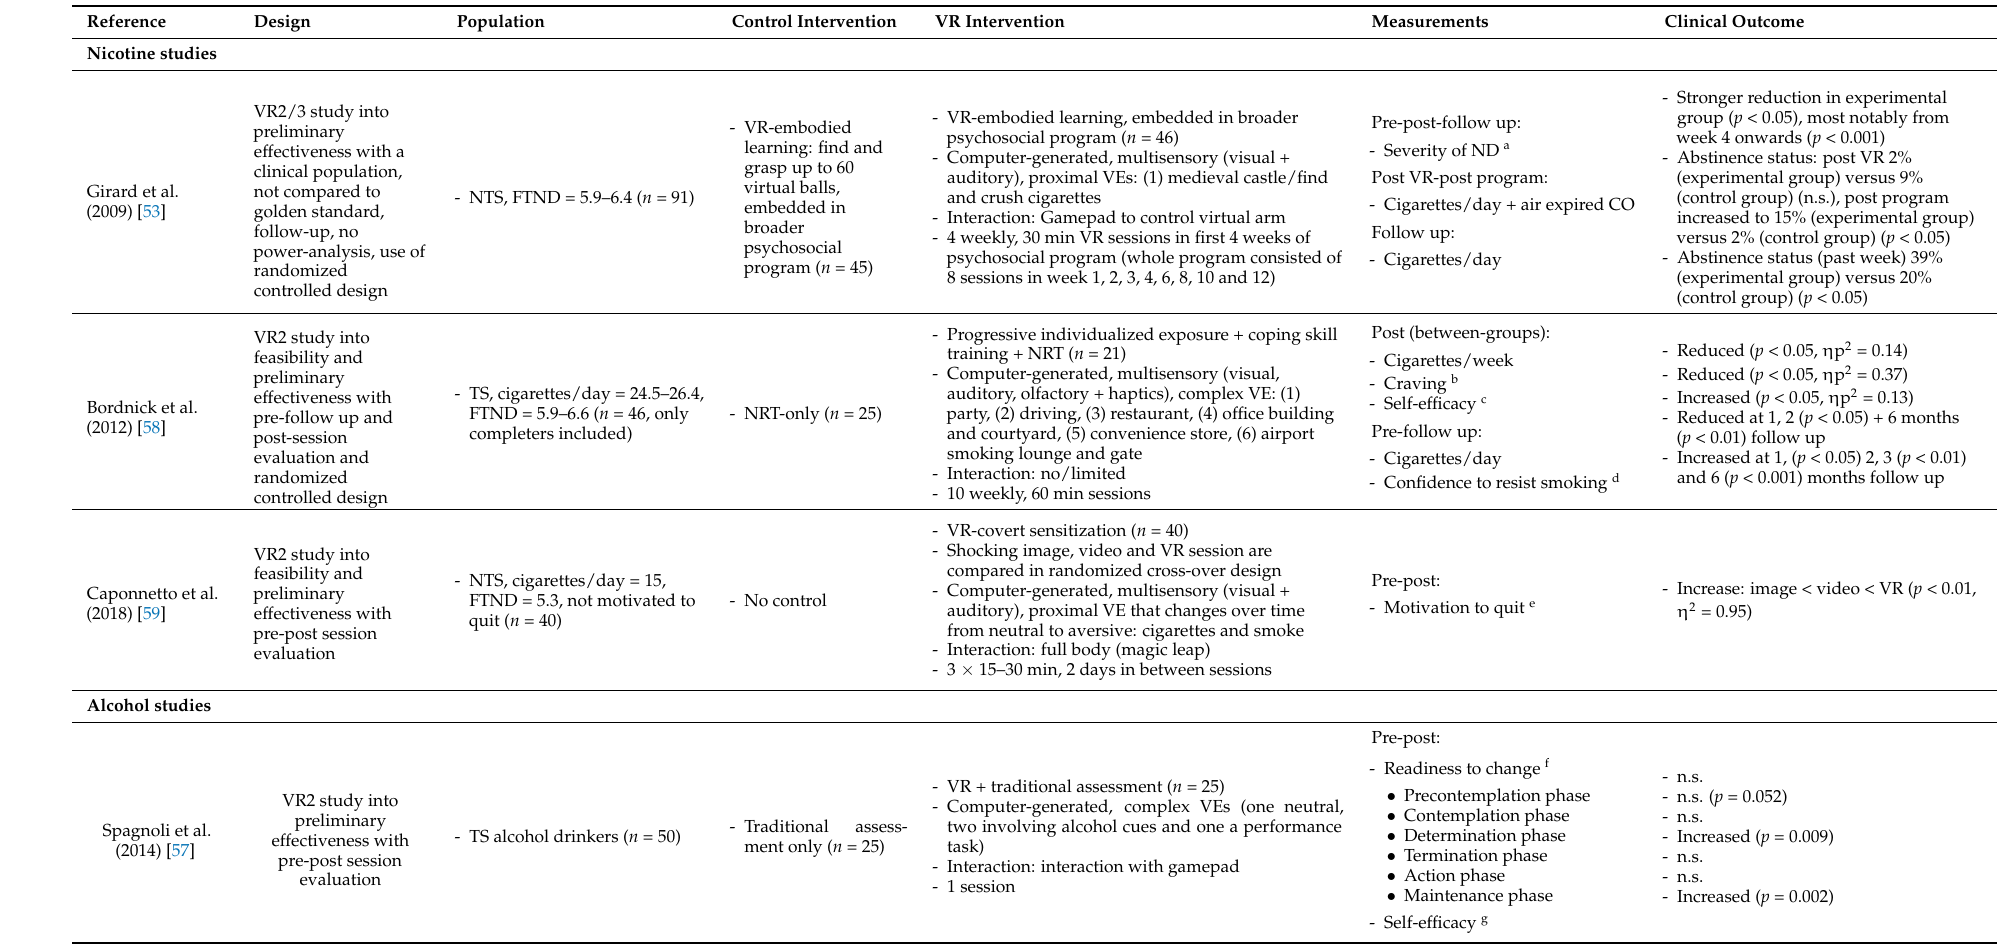
Table 4. Other Virtual Reality (VR) treatment